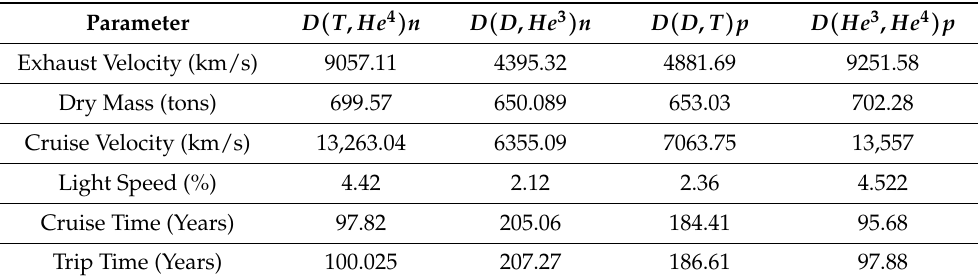
Table 4. Calculations for Resolution flyby probe using different fusion fuel models from numerical code input options carrying 150-ton